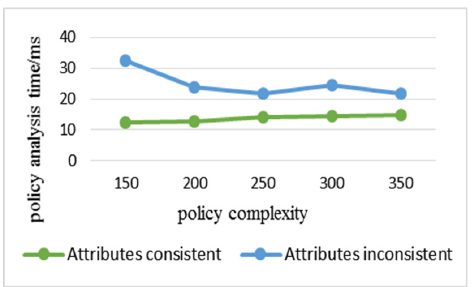
Figure 9. Time consumption in the case of attribute matching and mismatch.